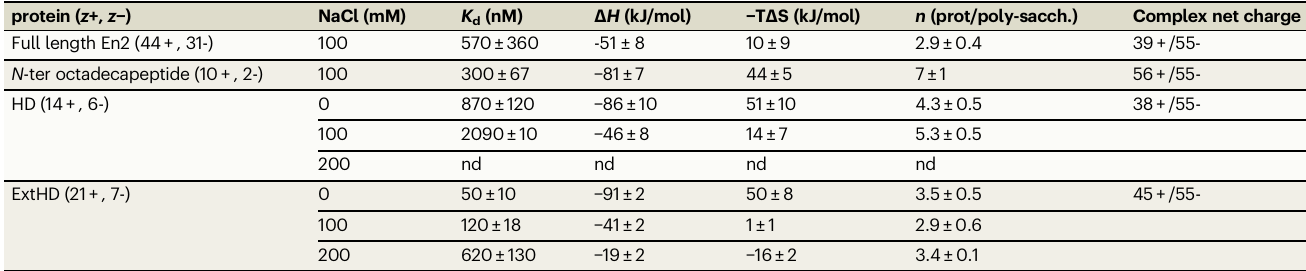
Table 1 | Interaction thermodynamics of the N -ter octadecapeptide and proteins with heparin (12 kDa, net charge about − 55), studied by